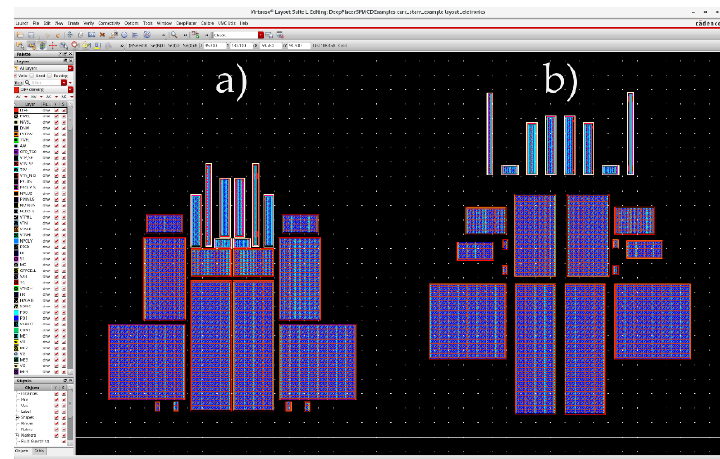
Figure 7. Placements generated for the VCOTA: ( a ) generated by this work, ( b ) designed by a human expert designer [25] . Table 5. Comparison of the automatically produced and human-designed floorplan solutions.